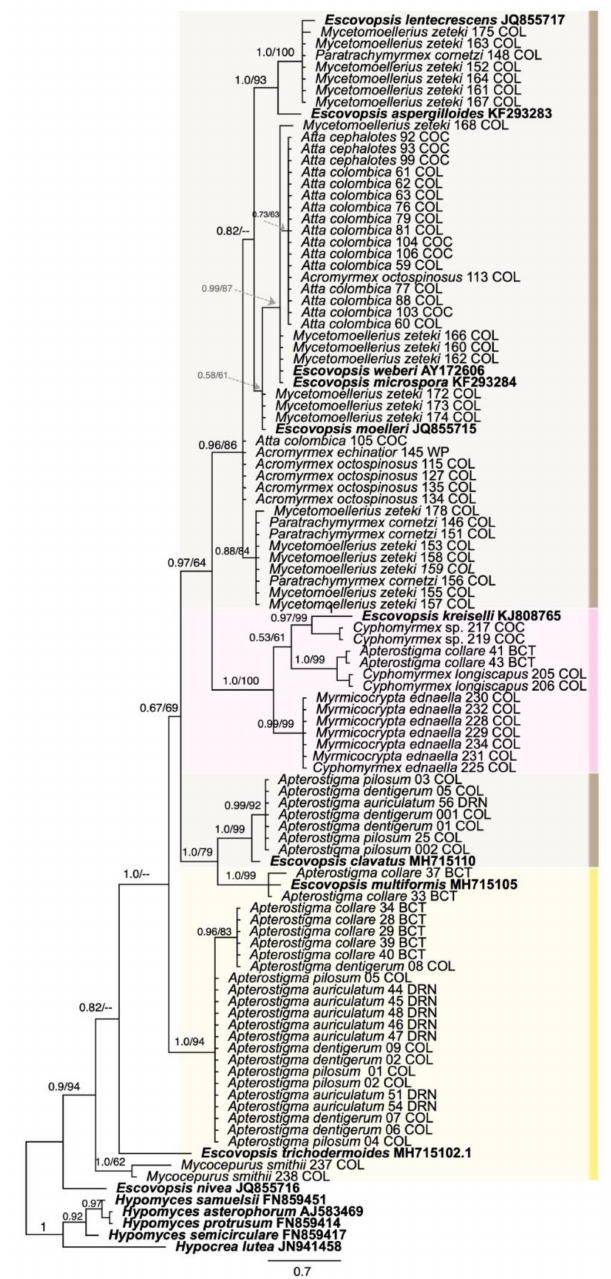
Figure 1. Phylogeny based on Large Subunit rRNA (LSU) of Escovopsis strains from fungus-growing ant gardens. The phylogenetic tree shown is based on the Bayesian tree topology. Each fungal strain isolated as part of this study is indicated by the species name of the ant host garden from which the Escovopsis was isolated, and all other strains are indicated by their genus and species name, followed by the Genbank accession number. Hypocrea lutea was used as an outgroup. Different colors indicate the Escovopsis morphotypes shown in the phylogenetic analyses. The numbers on branches indicate the posterior probabilities and the bootstrap support values, respectively. Only bootstrap supports ≥ 50% of ML and the posterior probability values ≥ 0.5 of BI analyses are indicated above or below the respective branches. The provinces from which each strain was isolated are indicated by the following abbreviations: PA, Panam á ; COC, Cocl é ; COL, Col ó n; DRN, Dari é n; BCT, Bocas del Toro; WP, West Panam á . Scale bar 0.7 substitutions per